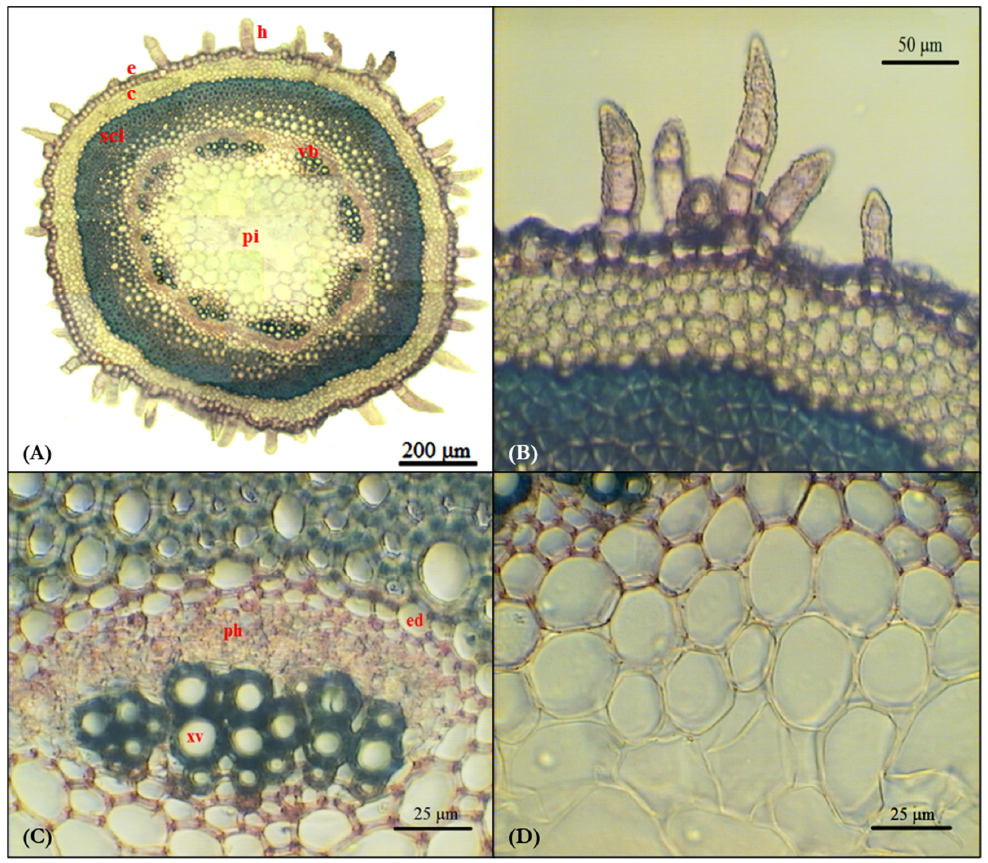
Figure 3. Cross section of the stem; (A) Ensemble; (B) Portion with cortex; (C) A vascular bundle of the stele; (D) Pith